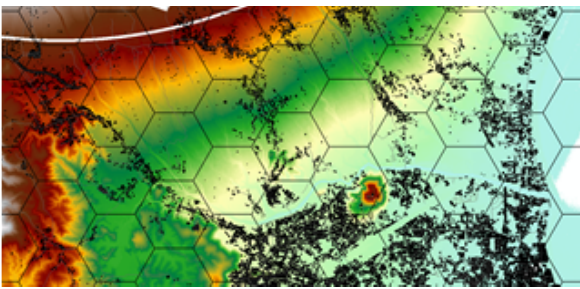
Figure 2. Tessellated DTM + OSM Building is